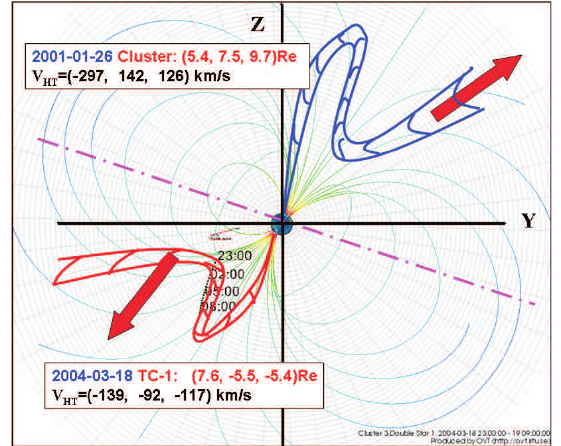
Fig. 4. Schematic drawing of a global view of flux rope in the Y- Z plane of GSM coordinates. The red arrows show the moving directions of flux ropes, and the pink dash line shows the suggested location of reconnection